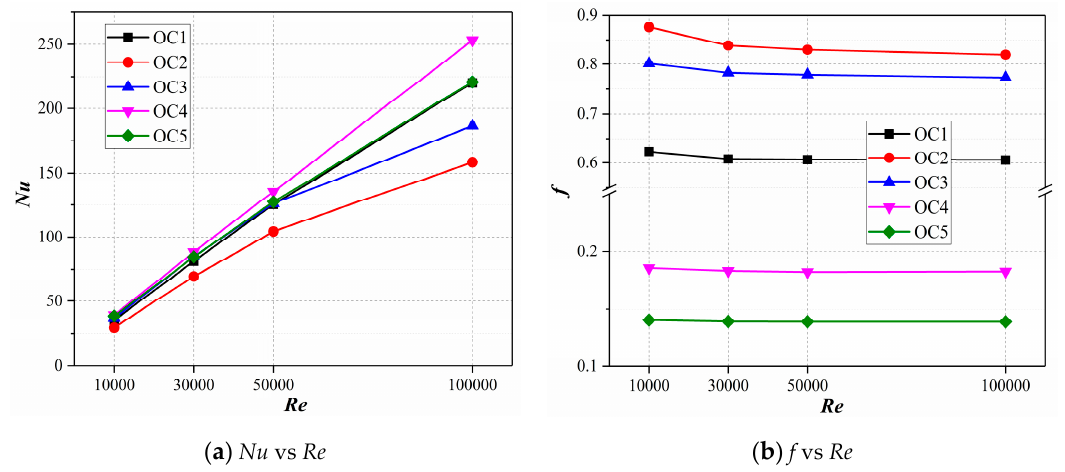
Figure 8. Variations of Nusselt number and friction with Re for different channel outlet configurations.